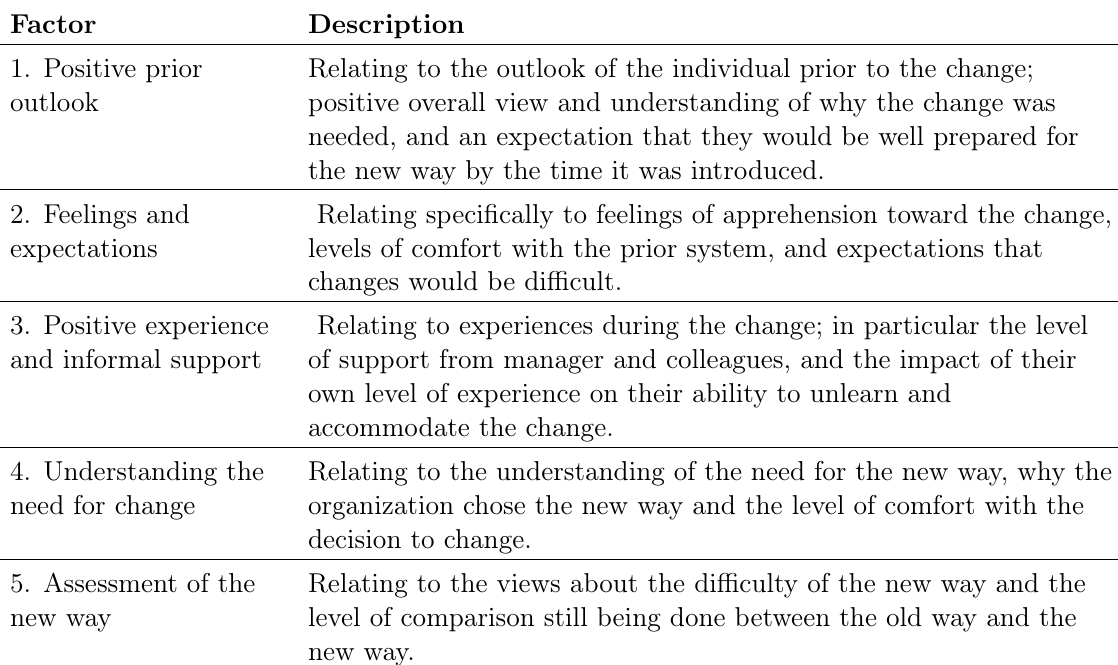
Table 3. Becker’s Factors that Influence Unlearning at the Individual Level (Source: Becker (2010, p.